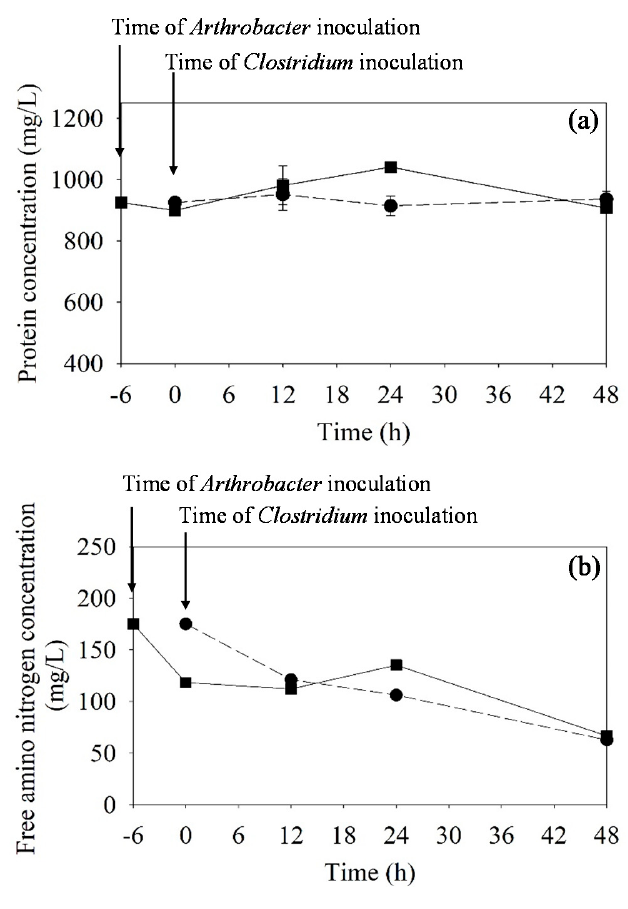
Figure 3. Profiles of protein ( a ) and free amino nitrogen (FAN) ( b ) concentrations in the fermentation broth during ABE fermentation by mixed cultures of Arthrobacter sp. and C. beijerinckii TISTR 1461 (inoculating C. beijerinckii after 6 h of Arthrobacter cultivation, ■ ) and by a single culture of C. beijerinckii using OFN gas flushing ( ● ).